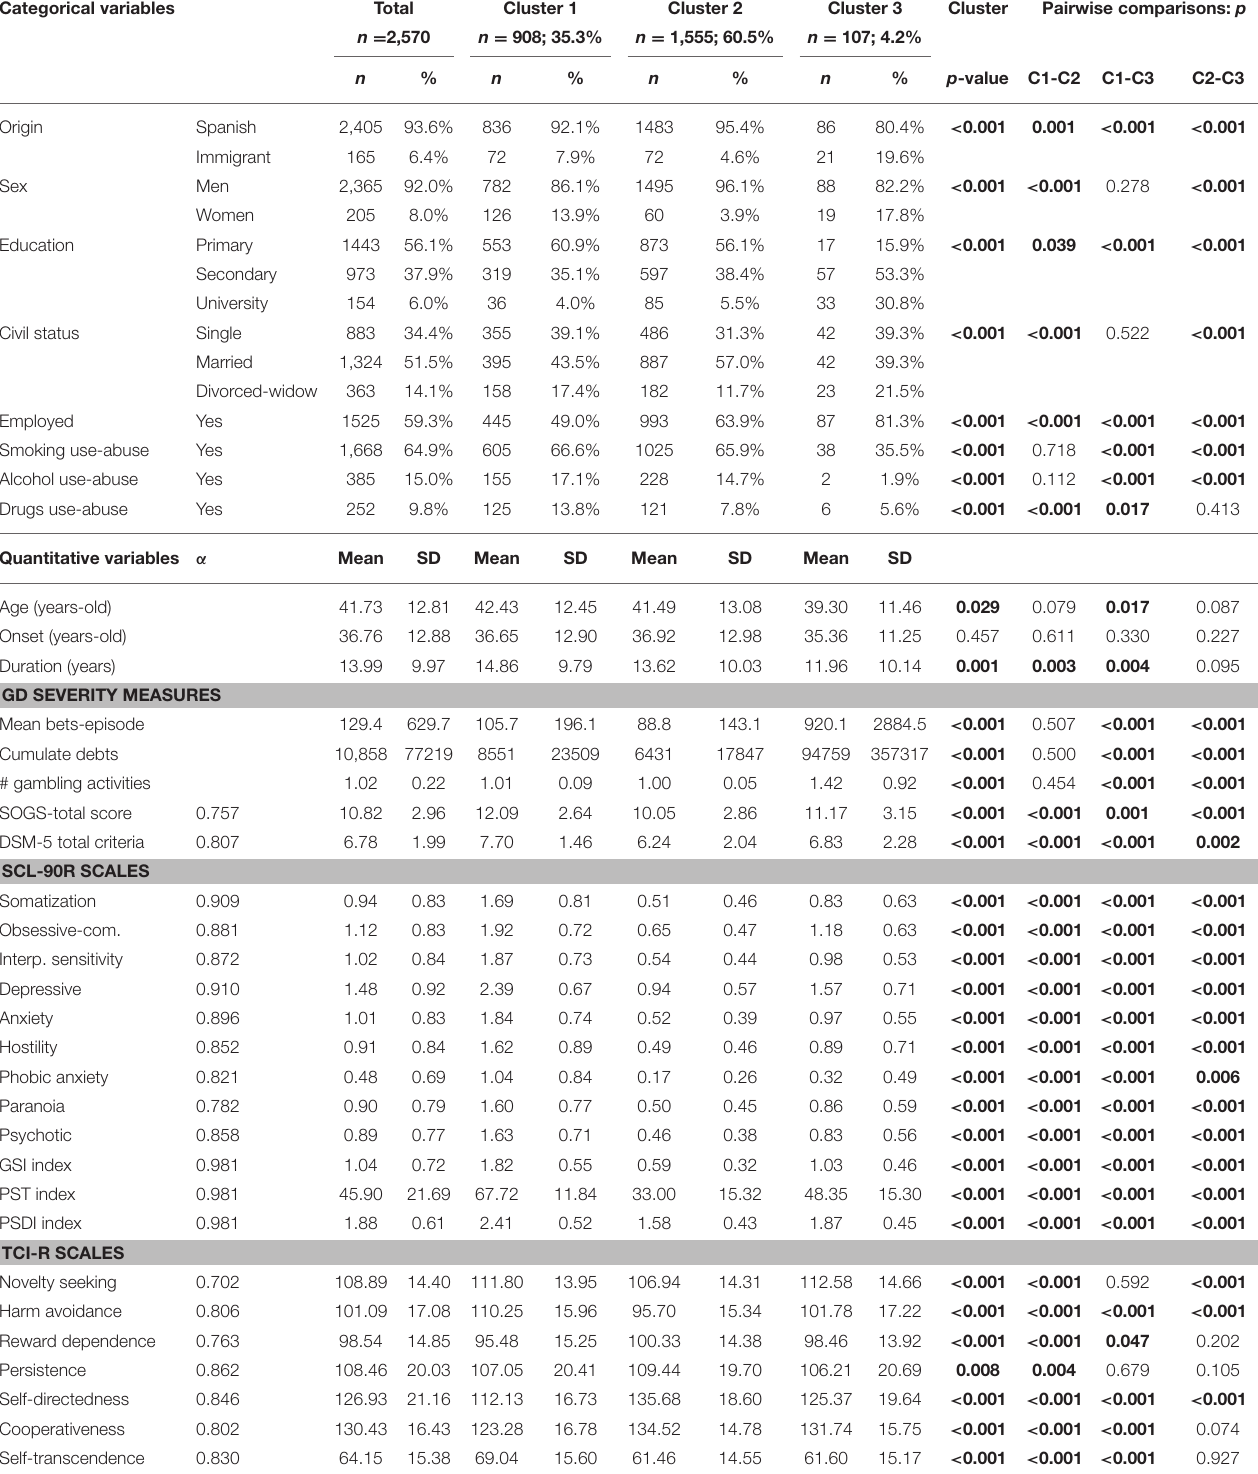
TABLE 1 | Cluster composition and comparison between groups. Categorical variables Total Cluster 1 Cluster 2 Cluster 3 Cluster Pairwise comparisons: